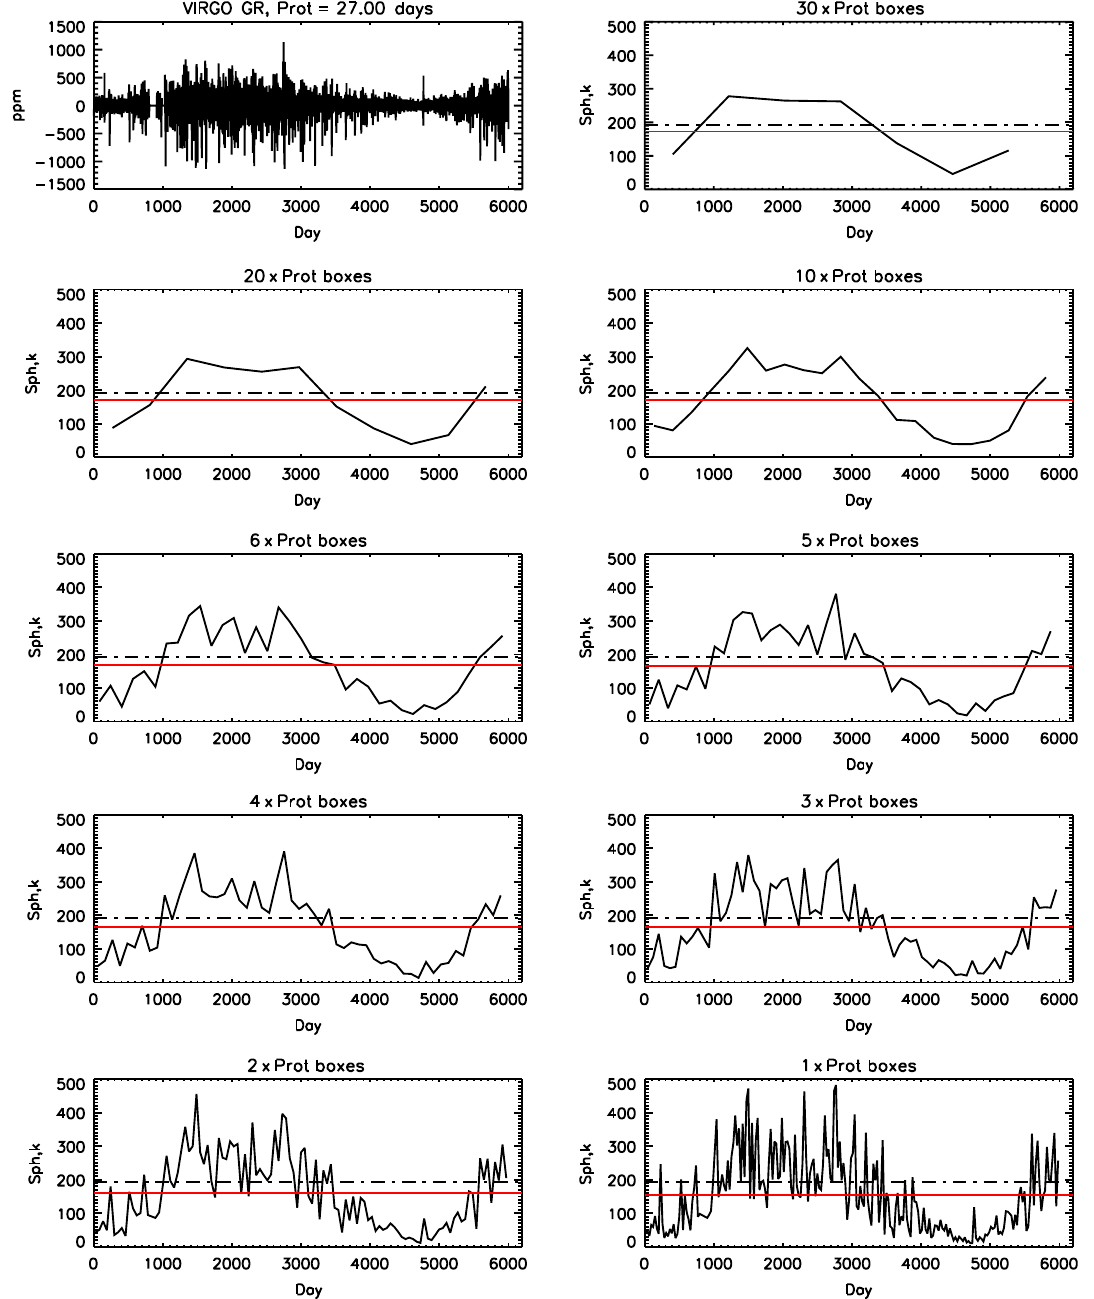
Fig. 1. Time series from the VIRGO/SPM instrument obtained with the green and red channels as described in Section 3.1 (top-left). Standard deviation for VIRGO data using subseries of size k · P rot with k = 1, 2, 3, 4, 5, 6, 10, 20, and 30 (from bottom right to top right). The black dot dash line represents the global magnetic index S ph and the red triple dot-dash line corresponds to the mean magnetic index, S ph ; k (cid:2) (cid:3) , computed as described in Section